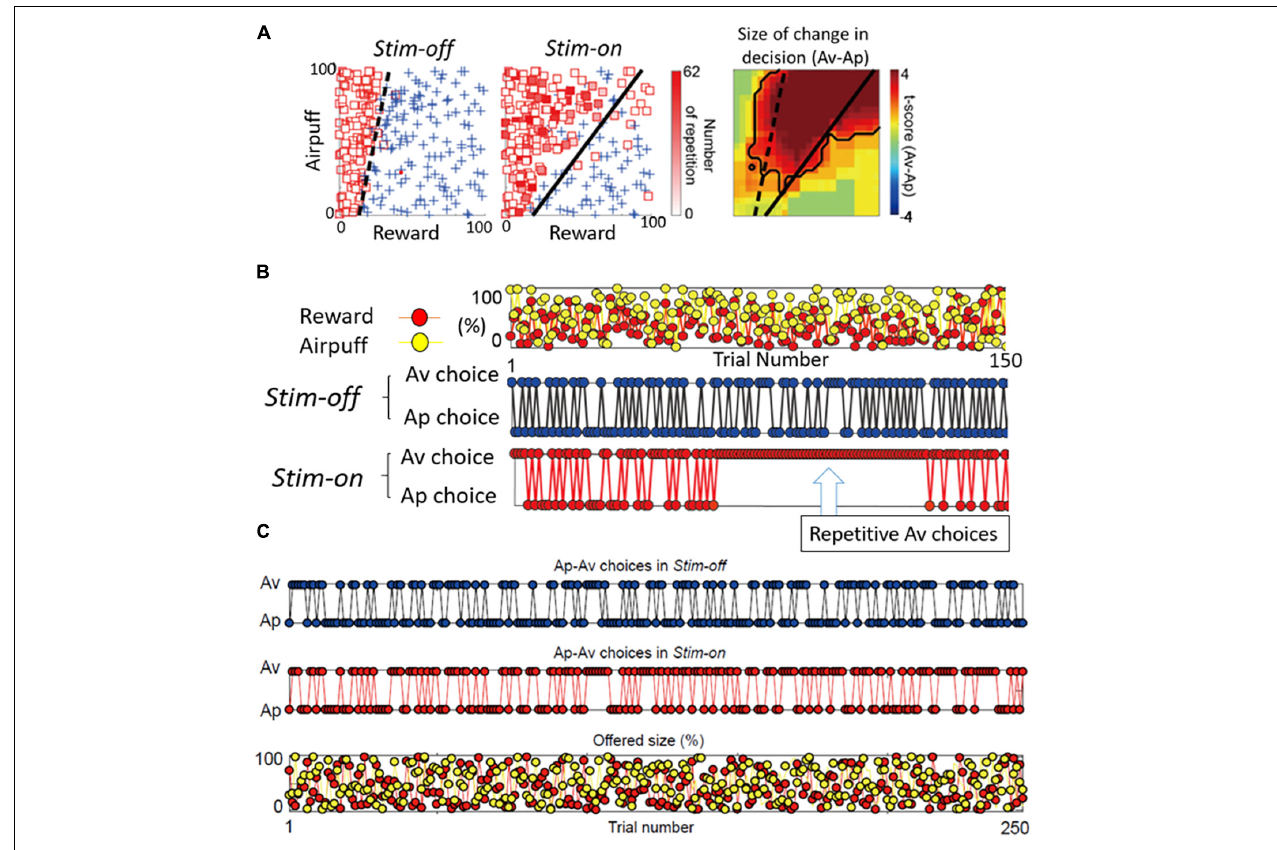
FIGURE 6 | Primate CN is causally involved in persistent pessimistic decision-making. (A) An example of a monkey’s decision-making. Changes in decision-making patterns (avoidance: square, approach: cross) due to microstimulation (left: before stimulation, middle: during stimulation). Blue cross indicates approach, and red square indicates avoidance. The color of each square is filled in according to the number of repeated avoidances. It can be seen that there were many repeated avoidances during microstimulation. (Right) Local stimulation of the striatum significantly increased avoidance decisions (Fisher’s exact test, P < 0.05). (B) CN stimulation caused an abnormal continuous avoidance choice. (Top) The same reward (red circle) and punishment (yellow circle) sequences were presented before and during stimulation. (Middle) The decision to approach/avoidance decisions are shown in the order of trial numbers. (Bottom) A sequence of abnormal repeated avoidance choice was found during stimulation. (C) pACC stimulation did not cause a continuous avoidance choice. Sequences of the Ap-Av decisions in the Stim-off (top) and in the Stim-on (middle) blocks, and the sequence of the reward (red circles) and airpuff (yellow circles) sizes (bottom) (Adapted from Amemori et al.,